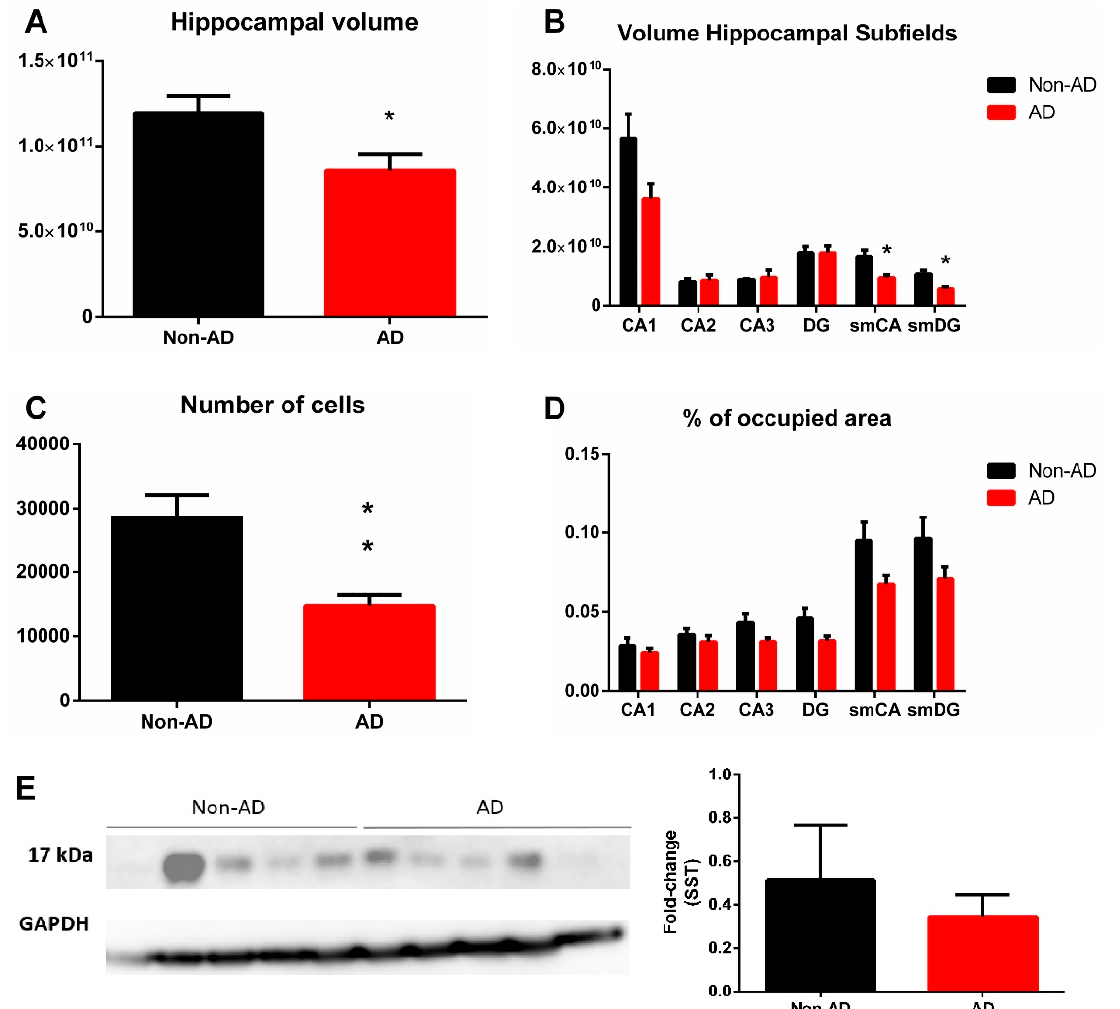
Figure 4. Quantification of volume and somatostatin expression in the hippocampus. Hippocampal volume was reduced in AD ( A ), and the molecular layers of CA and DG regions were specifically involved ( B ). The number of somatostatin-expressing cells was diminished in the whole hippocampus ( C ), but only a tendency (not significant) was observed in the areas occupied by somatostatin fibers ( D ). Western blot quantification did not show a significant reduction in somatostatin expression in the hippocampus ( E ). For volume, number of cells and somatostatin fibers quantification N = 10 formalin-fixed cases (AD = 5 and non-AD = 5) and 4 sections per case were analyzed. Western blot quantification was performed using N = 10 fresh-frozen cases, AD = 5 and non-AD = 5. See Table 1 and supplementary stereological data for further information. * Corresponds to p -value < 0.05.